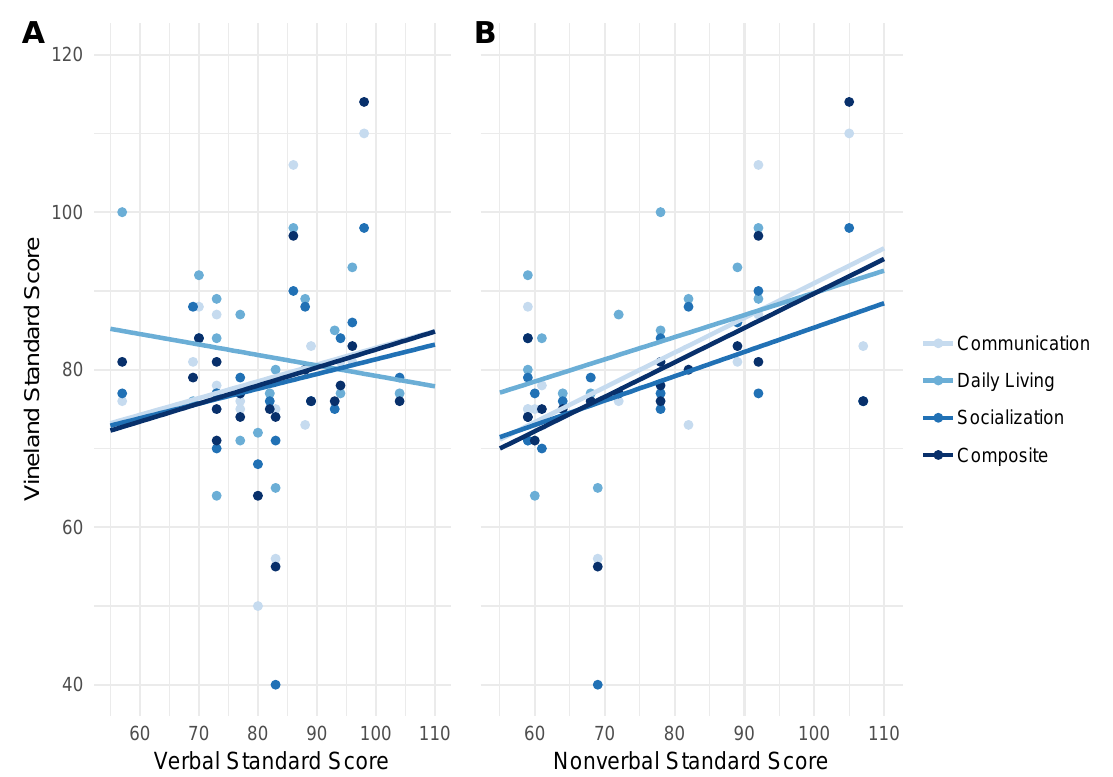
Figure 3. Correlations between cognition and adaptive behavior. ( A ) Correlations of the DAS-II verbal